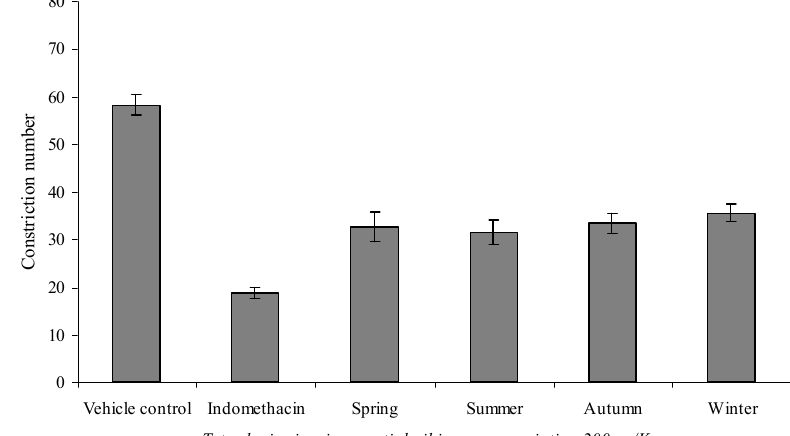
Figure 3. Effect of the essential oil of Tetradenia riparia and indomethacin (10 mg/kg) on mouse abdominal constrictions induced by acetic acid (0.6%, i.p.). 200 mg/kg p.o. Data are expressed as mean ± SEM (n = 8-10 animals per group). P < 0.05 (Student’s t test) as compared to the vehicle control group.